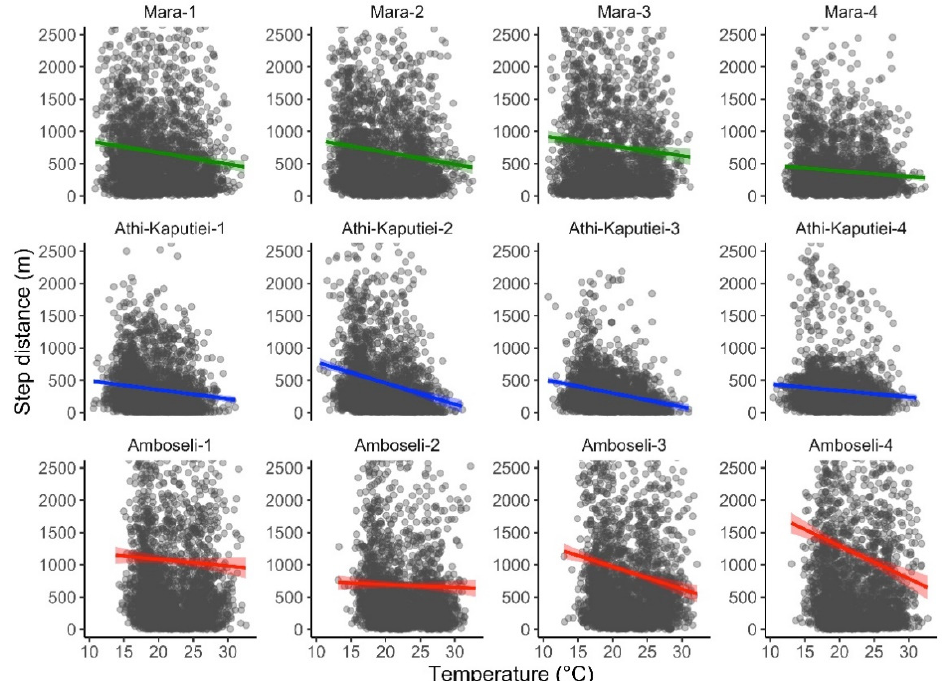
Figure 3. Relationship between step length and air temperature for blue wildebeest. GPS tracking data were obtained from 12 individuals from three populations in Kenya: the Maasai Mara/Loita Plains (green), Athi-Kaputiei Plains (blue), and Amboseli Basin (red). Hourly air temperature at 2 m over the ground was obtained from the ERA5-Land dataset. All data are from 2011.